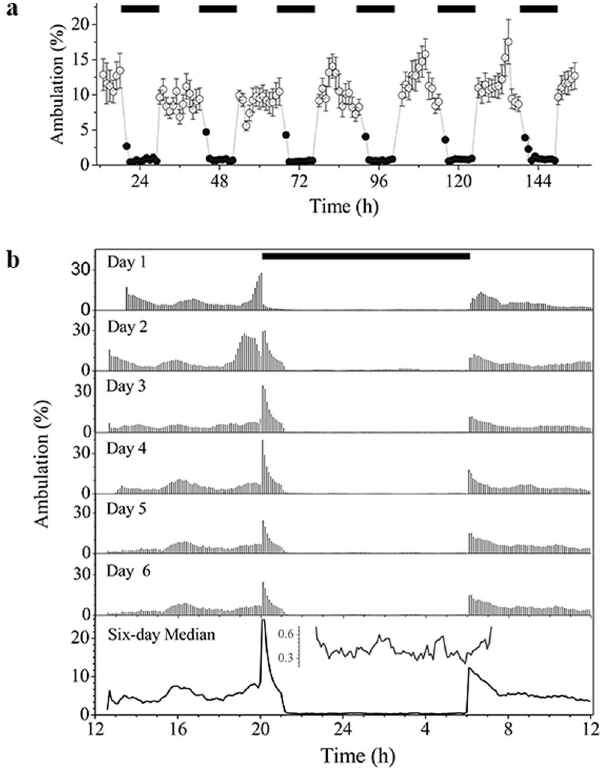
Figure 1. Locomotor activity of female Japanese quail in a home-cage environment. ( a ) Hourly mean values of the percent of time spent ambulating of the 24 quails tested (Mean ± SEM). ( b ) Representative actogram of an animal with both ultradian and circadian rhythms (see analysis of this time series in Figs 2 and 3). Actogram was constructed using 6-min bins, and the percentage of time spent ambulating in each 6 min bin ranged from 0 to 45%. Black bar represents the dark period. Last panel represents the median actogram estimated by calculating the median percentage of time spent ambulating in each 6 min bin over the 6 day period. The inset displays a magnification of the nighttime period (20–34 h). Peaks in median actogram provide visual evidence of underlying ultradian ( < 24 h) rhythms, both during daytime and nighttime